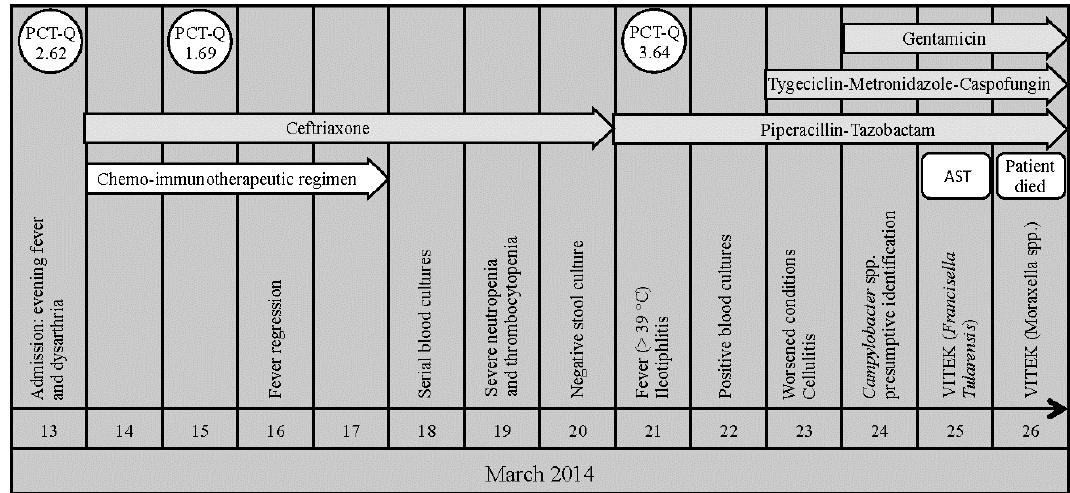
Figure 1. The patient’s clinical course. Procalcitonin (PCT-Q) levels were expressed as ng/mL. Antimicrobial susceptibility testing (AST) was performed by Etest ® , according to the Clinical and Laboratory Standards Institute (CLSI) breakpoints for non-Enterobacteriaceae.